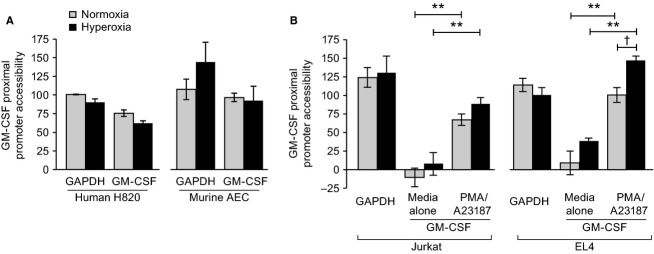
Accessibility of GM-CSF and GAPDH proximal promoters. Cells were exposed to normoxia or hyperoxia (80% oxygen) for 48 h in media alone. Chromatin DNA was isolated as outlined in Methods from cells, treated or untreated with DNase. RT-PCR of human and murine GM-CSF and GAPDH proximal promoters were performed as described to provide an estimate of proximal promoter accessibility. Lung epithelial cells (human H820 cells and primary murine AEC, A) were cultured in media alone. T-cell lines (human Jurkat cells and murine EL4 T cells, B) were cultured in media alone or were exposed to PMA (20 ng/mL) and A23187 (1 μmol/L) for the last 16 h of the experiment. Data are analyzed as the Ct differential between the DNase digested sample and undigested sample. The value for GAPDH, an accessible housekeeping gene, under normoxic (and in T cells unactivated) growth conditions was assigned a value of 100%. Data are the mean ± SEM of three individual experiments. **P < 0.001; †P < 0.05